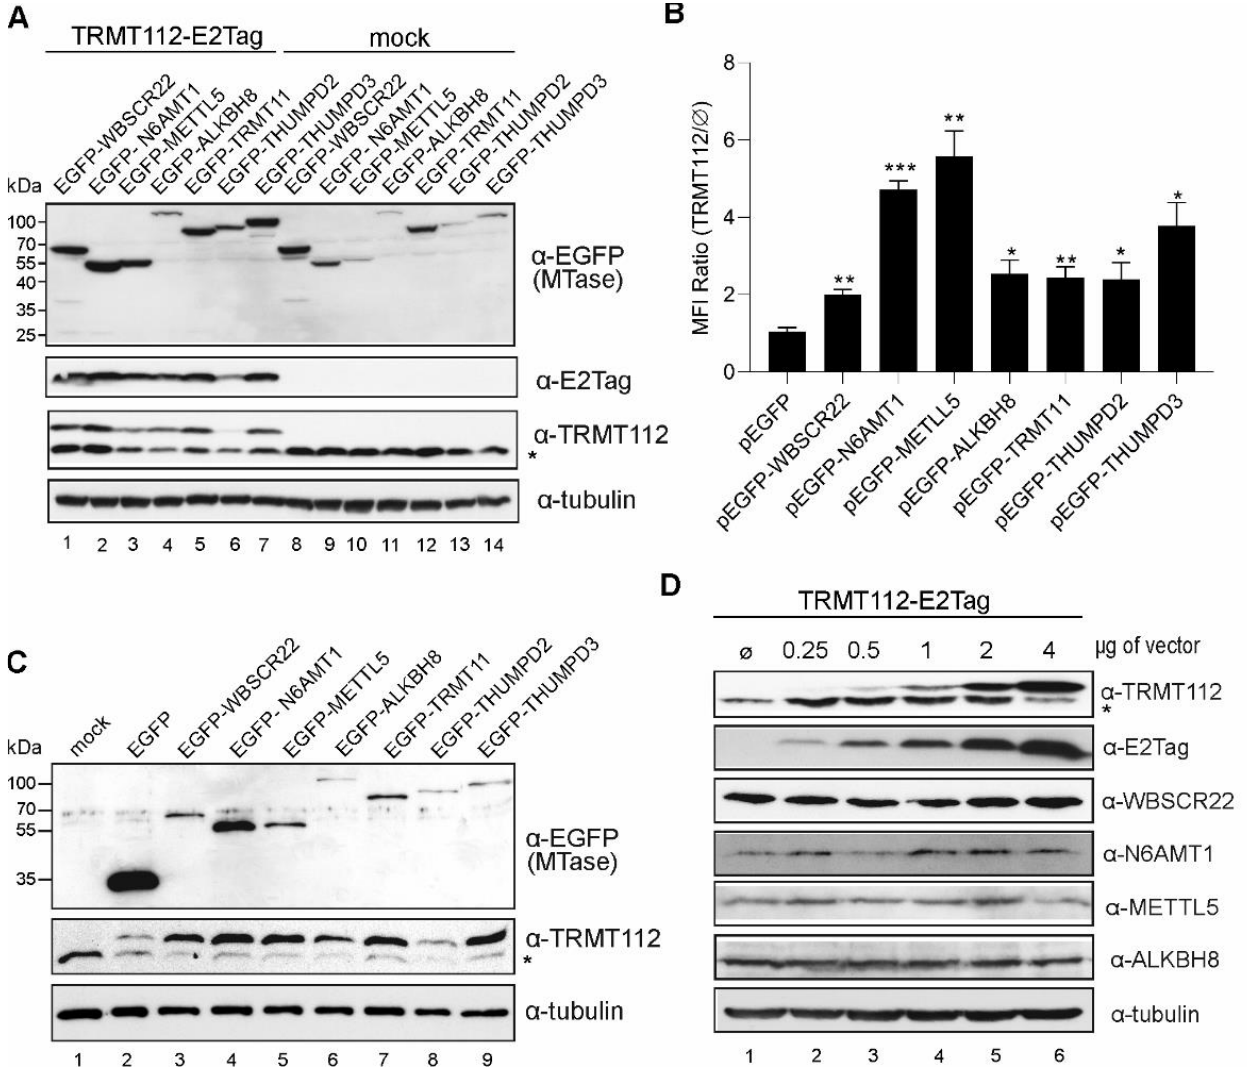
Figure 3. TRMT112 and MTases mutually stabilise each other’s expression in cells. ( A ) TRMT112 stabilises the expression of partner MTases in cells. The EGFP-fused MTases were expressed with and without TRMT112-E2Tag in U2OS cells, and their expression was analysed by Western blot using antibodies against EGFP (to detect MTases), E2Tag (recombinant TRMT112), TRMT112 (both endogenous, marked with asterisk, and recombinant TRMT112, upper band) and β -tubulin (loading control). ( B ) Flow cytometry analysis of the expression level of EGFP-fused proteins after co-expres- sion with TRMT112. Mean fluorescent intensity (MFI) ratios are calculated as relative values of me- thyltransferase expression with and without TRMT112. EGFP alone was set to 1. Average of three biological replicates are shown. The difference in the sample value compared to control sample value is statistically significant with p-value * < 0.05, ** < 0.01 and *** < 0.001. ( C ) TRMT112 protein expression is stabilized by co-expression of its partner MTases. Cells were analysed 48 h after trans- fection with Western blotting using antibodies against EGFP, TRMT112 and tubulin. Mock-cells without added expression vectors. ( D ) Increasing TRMT112 protein level in cells does not affect the endogenous level of its partner MTases. U2OS cells were transfected with increasing amounts of